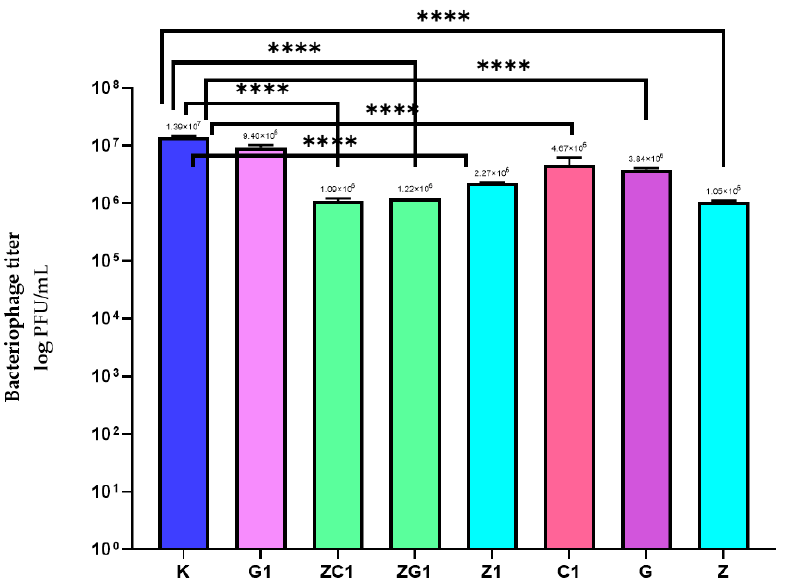
Figure 6. The influence of coatings on bacteriophage titer. K–PE film; G1–PE film covered with the MHPC coating containing 0.0125 g of geraniol in 100 mL carrier; C1–PE film covered with the MHPC coating containing 0.0125 g of carvacrol in 100 mL carrier; G–PE film covered with the MHPC coating containing 5 g of geraniol in 100 mL carrier; Z–PE film covered with the MHPC coating containing 0.082 g ZnO nanoparticles in 100 mL carrier; Z1–PE film covered with the MHPC coating containing 0.041 g ZnO nanoparticles in 100 mL carrier; ZG1–PE film covered with the MHPC coating containing 0.041 g ZnO nanoparticles and 0.0125 g of geraniol in 100 mL carrier; ZC1–PE film covered with the MHPC coating containing 0.041g ZnO nanoparticles and 0.0125 g of carvacrol in 100 mL carrier, one-way ANOVA: ns—not significant; *— p < 0.05; **— p < 0.01; ***— p < 0.001; ****— p < − 0.0001.